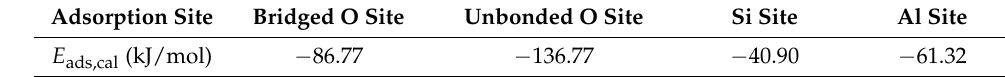
Table 6. The adsorption energy of ammonium on the four possible adsorption sites in the zeolite.